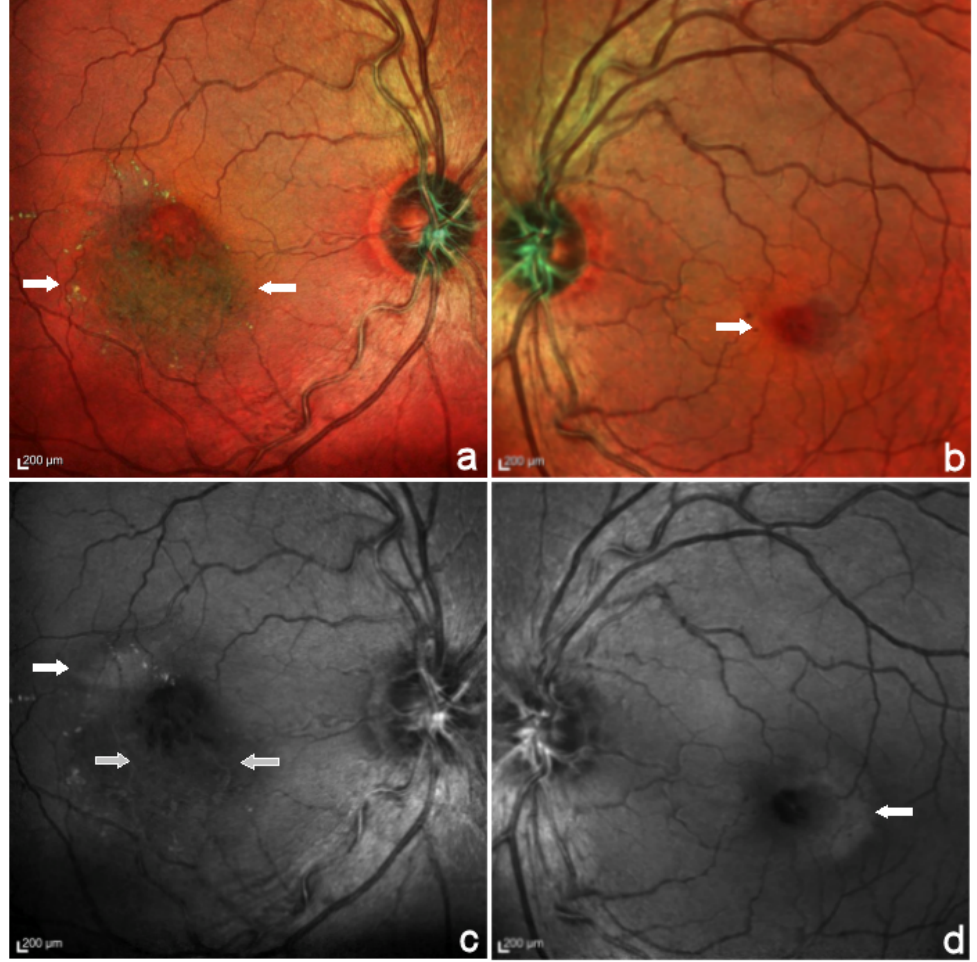
Figure 2: Multicolour composite images (MC) and blue reflectance images. The MC image showed greenish hue inferior to the fovea (between arrows) and yellow dots corresponding to the hard exudates (a). In the left eye MC composite image, the microaneurysms were clearly seen as dark red dots (arrow) (b). In the blue reflectance image, increased parafoveal reflectance was seen in both eyes (closed arrows) (c,d). Additionally, in the right eye it showed a clear distinction between hyperreflective vessels in the inferior parafovea and the hyporeflective appearance of other vessels in the blue reflectance image image (open